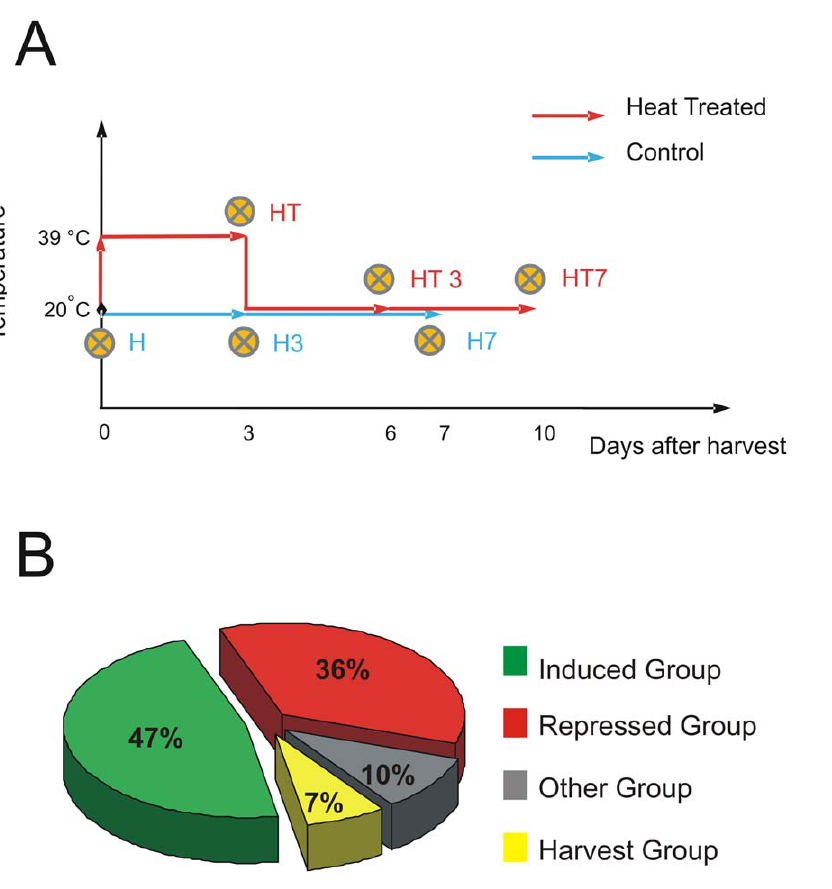
Figure 1. Treatments of peach fruits and clustering of the differential transcriptome. A. Schematic representation of Dixiland peach fruit samples employed for the transcriptomic analysis. The differential transcriptome was obtained comparing fruits at six different stages: harvest time (H); after 3 and 7 days of harvest (H3 and H7, respectively) along the normal ripening process (light blue arrows) at 20 u C; after the application of a heat treatment (upper red arrow) of 39 u C during 3 days (HT) and after 3 and 7 days (HT3 and HT7, respectively) at 20 u C after the heat treatment (lower red arrows) at 20 u C. Both H3 and HT fruits have the same post-harvest lifetime. H7 and HT3 fruits have approximately the same post-harvest lifetime. However, HT7 fruits have no control counterparts of the same post-harvest lifetime. Crossed circles indicate the time-points of sample collection for the analysis. B. Pie chart representing the four clusters of unigenes of the differential transcriptome. Induced- and repressed- upon-heat-treatment unigenes were classified according to their expressional pattern (Table 1) and gathered into the IG and RG, respectively. These clusters represent 83% of the differential post-harvest transcriptome. OG includes unigenes whose differential expression pattern can not be related to the applied treatment. HG includes unigenes expressed at harvest stage and that are repressed during the ripening of fruits.